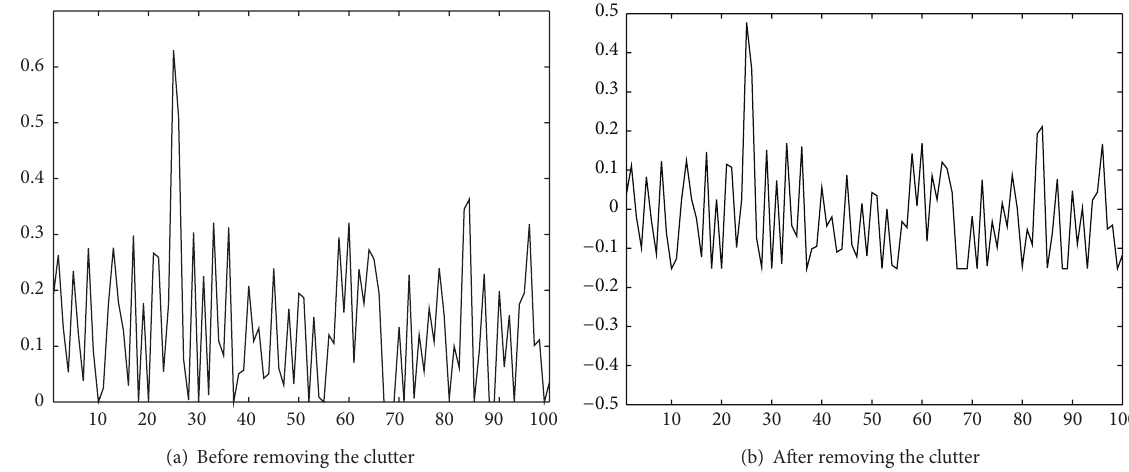
Figure 6: Adaptive background clutter suppression.